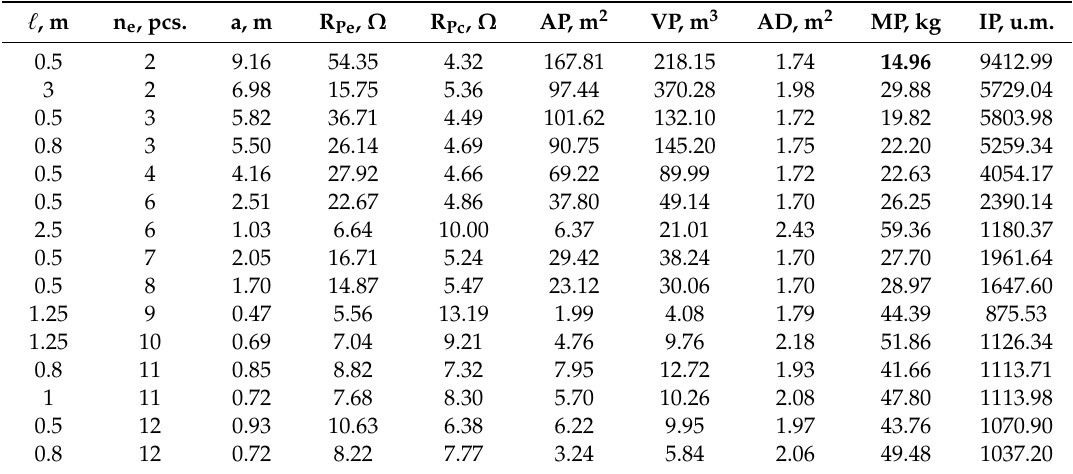
Table 1. Calculated data regarding the application of optimal criteria when sizing VEG, with linear electrode placement, for ρ p = 100 Ω m, r pn = 4 Ω